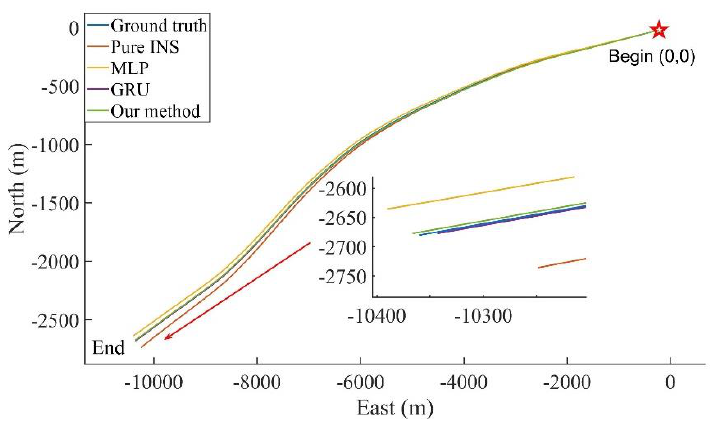
Figure 18. The horizontal position error result of 300 s outage of Experiment 1.